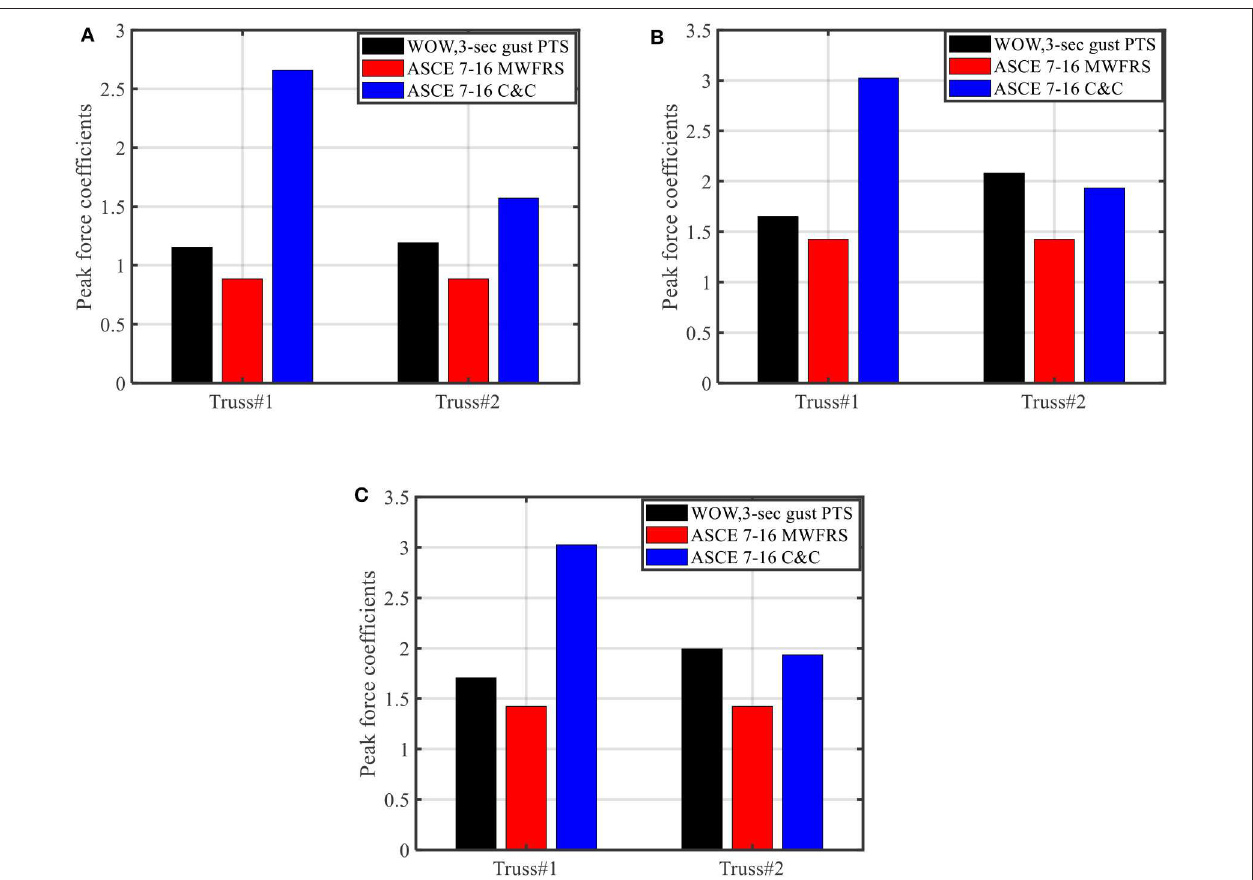
FIGURE 15 | Maximum uplift force coefficient from all wind directions, compared with ASCE 7–16. (A) Enclosed building. (B) Partially enclosed building (west wall). (C) Partially enclosed building (south